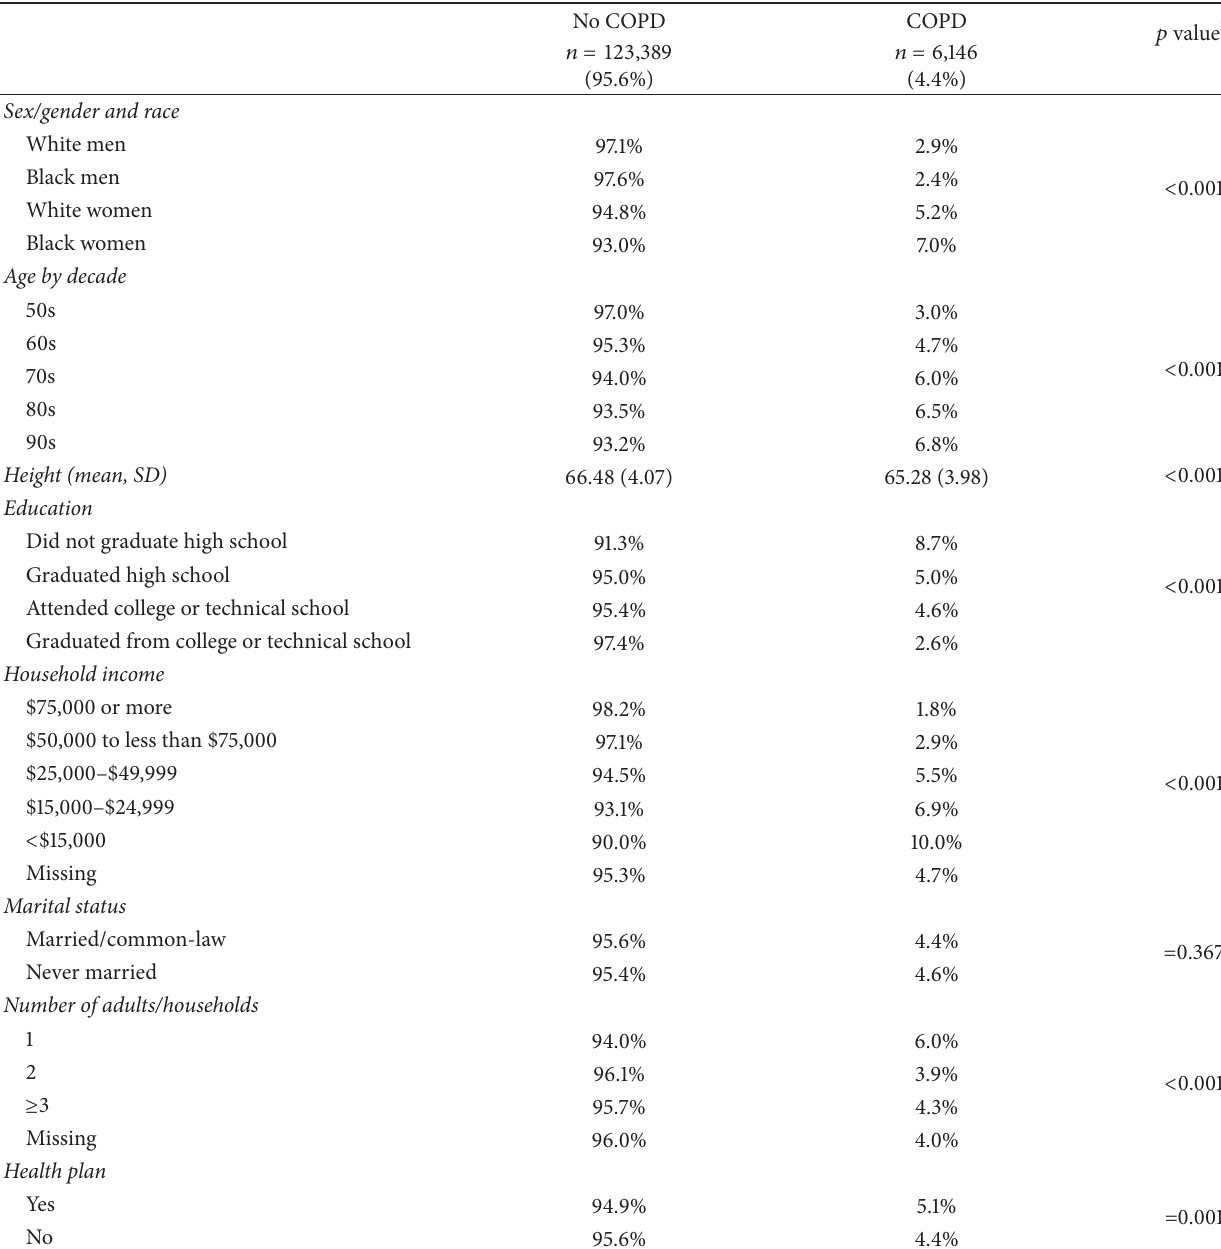
Table 1: Description of a sample of never-smoking Americans over the age of 50 according to COPD status ( 𝑛 = 129 , 535 ) 1